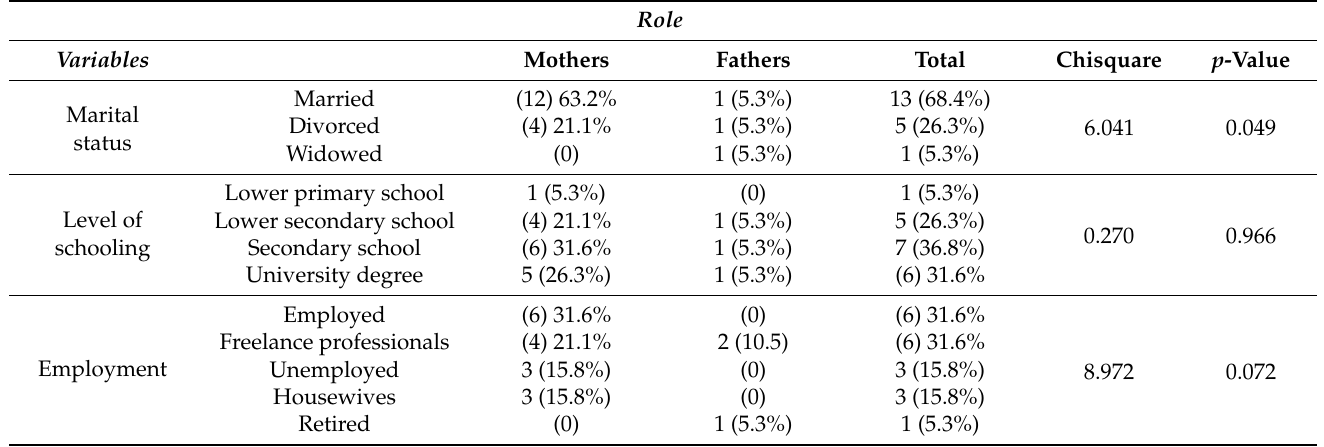
Table 1. Socio-demographic characteristics of the respondents, disaggregated for